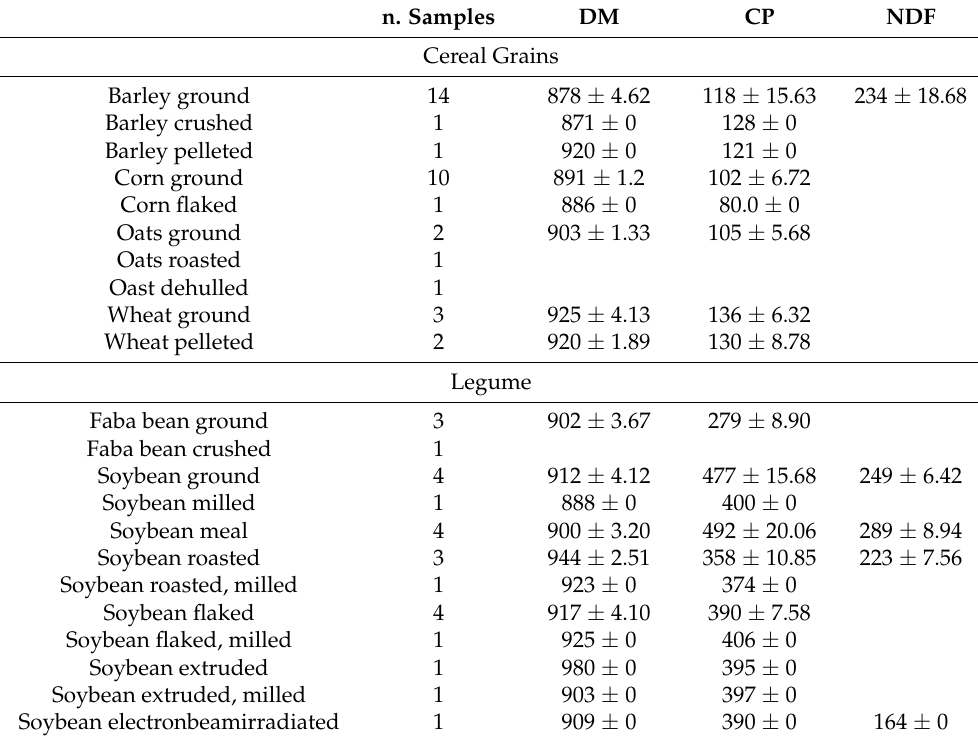
Table 1. Chemical composition (g/kg DM) of cereal and legume grains (means ± standard deviation of examined